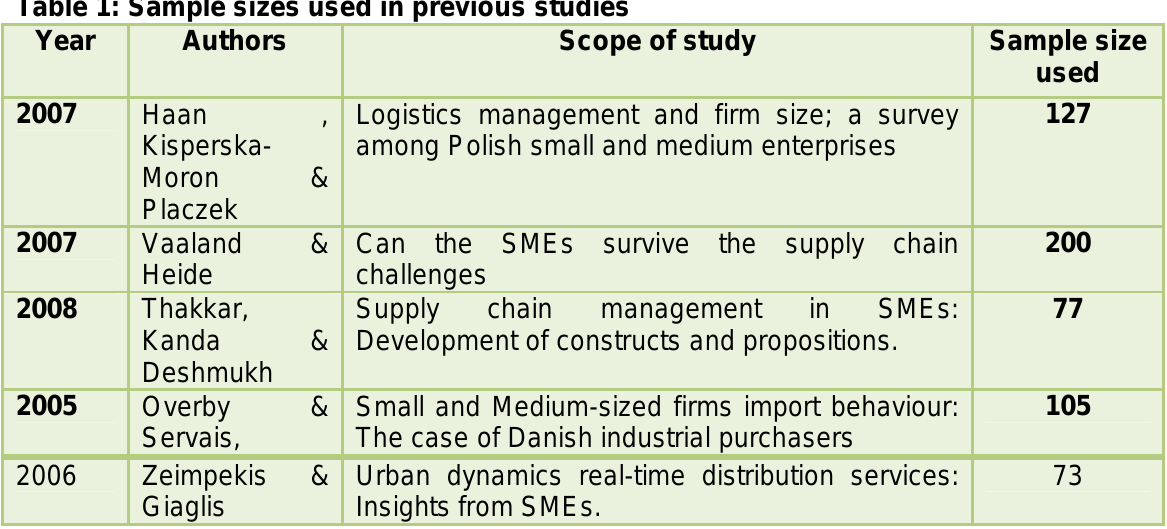
Table 1: Sample sizes used in previous